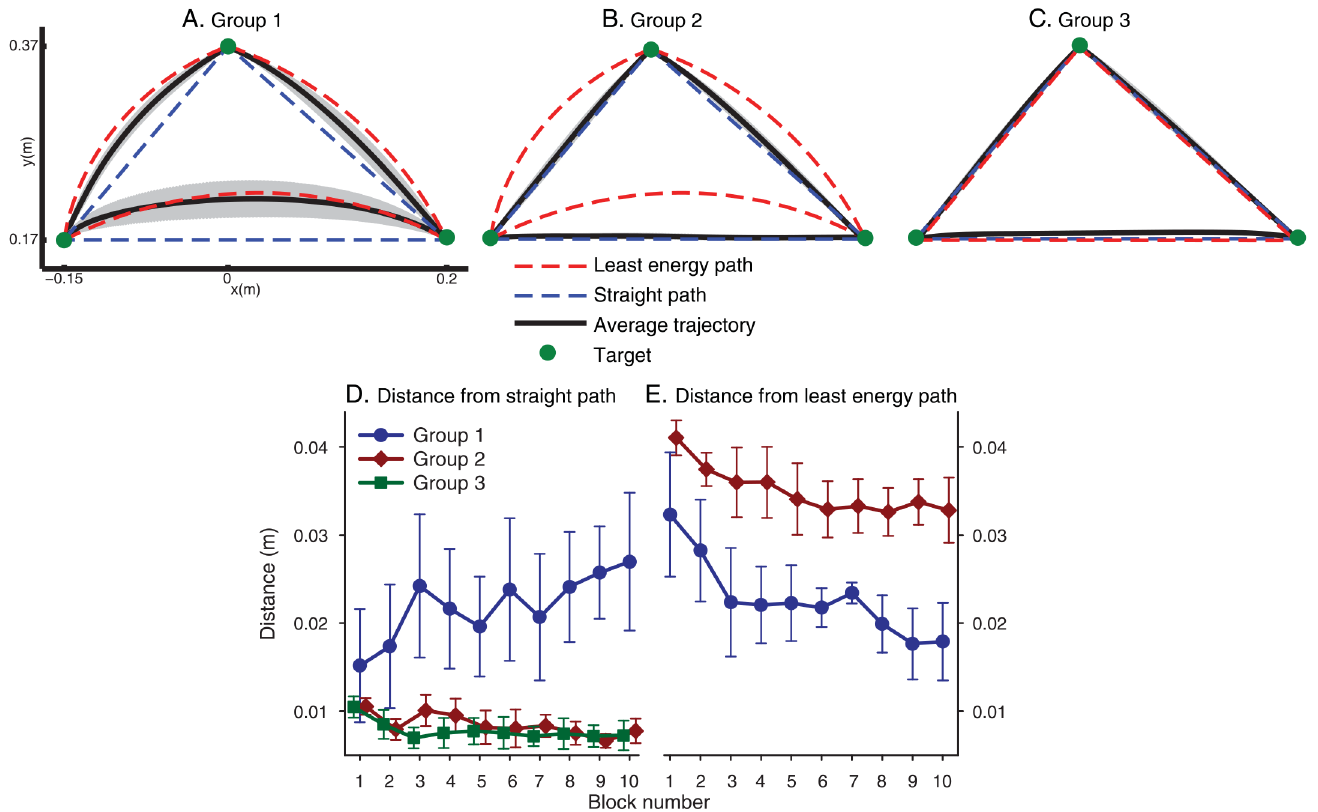
Fig 2. Results. (A) Average trajectories of participants in Group 1 (double pendulum vision / double pendulum haptics) during the last block. (B) Average trajectories of participants in Group 2 (point mass vision / double pendulum haptics) during the last block. (C) Average trajectories of participants in Group 3 (double pendulum vision / point mass haptics) during the last block. (D) Average discrete Fréchet distance from the straight path. (E) Average discrete Fréchet distance from the path of least kinetic energy. For Group 3, the straight path and the path of least energy were the same. Error bars and shaded area represent 95% confidence